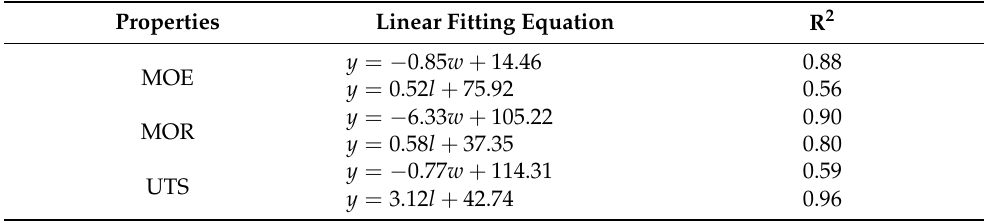
Table 3. The results of linear fits of mechanical properties of plantation Japanese larch (i.e., MOE, MOR, UTS) to ring width (w) and latewood percentage